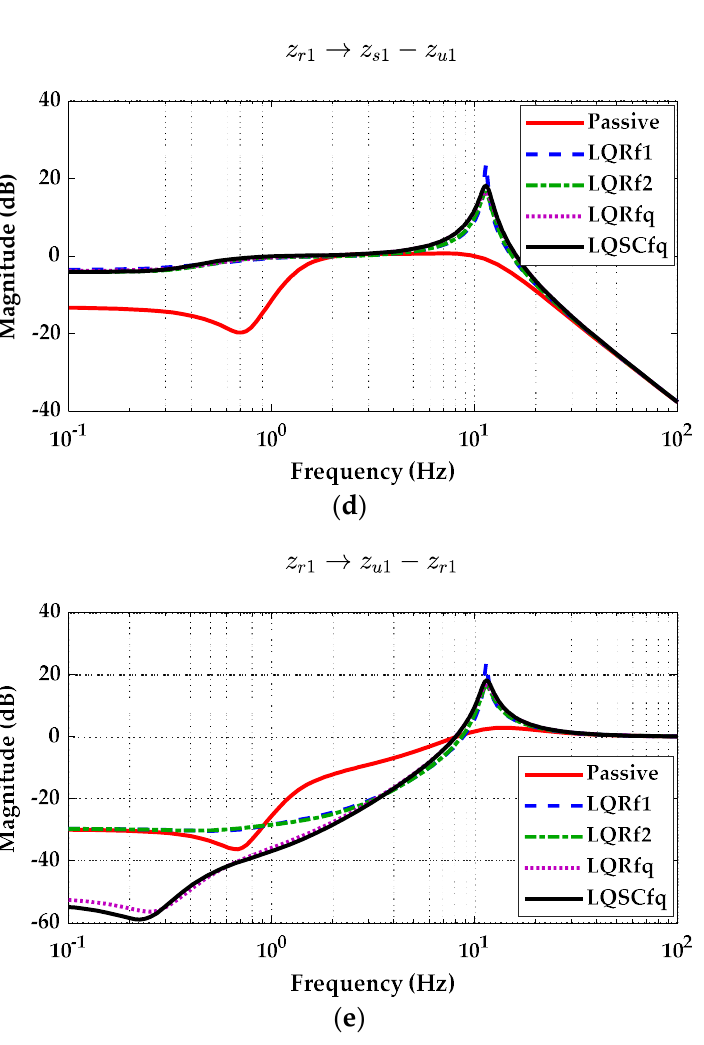
Figure 5. Frequency responses from the road profile z r 1 to each output for full-state feedback case. ( a ) Vertical acceleration of the sprung mass; ( b ) Roll angle of the sprung mass; ( c ) Pitch angle of the sprung mass; ( d ) Suspension stroke; ( e ) Tire deflection. Table 4. Gain matrices of LQR and